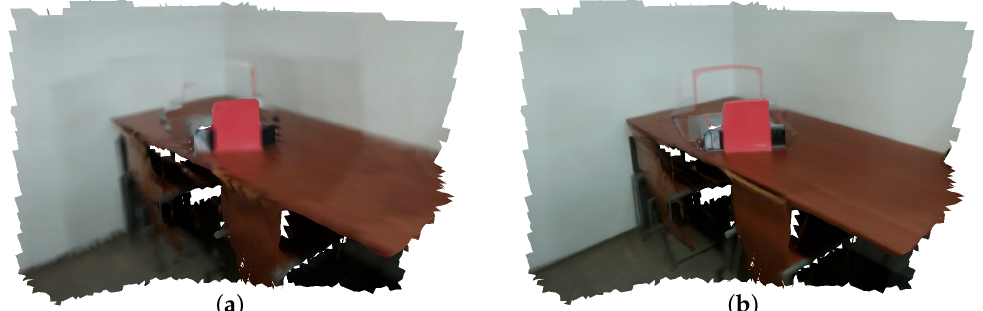
Figure 2. Using one or many images in texture mapping: ( a ) average-based approach; ( b ) winner- take-all approach. Images produced by OpenConstructor before final optimization ( a ) and after optimization ( b